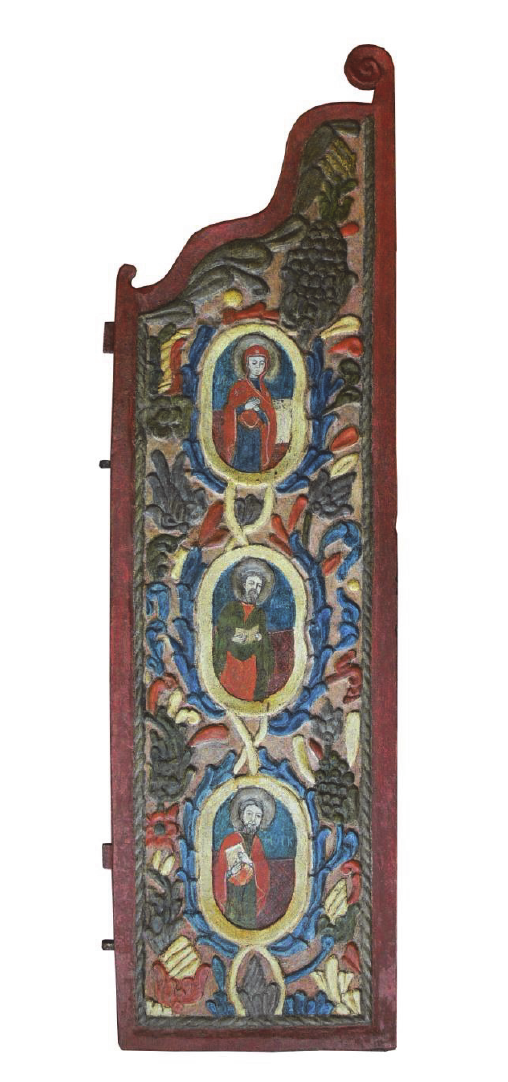
Figure 9: Restored Imperial Gate (left side) of Nicula wooden church Imperial